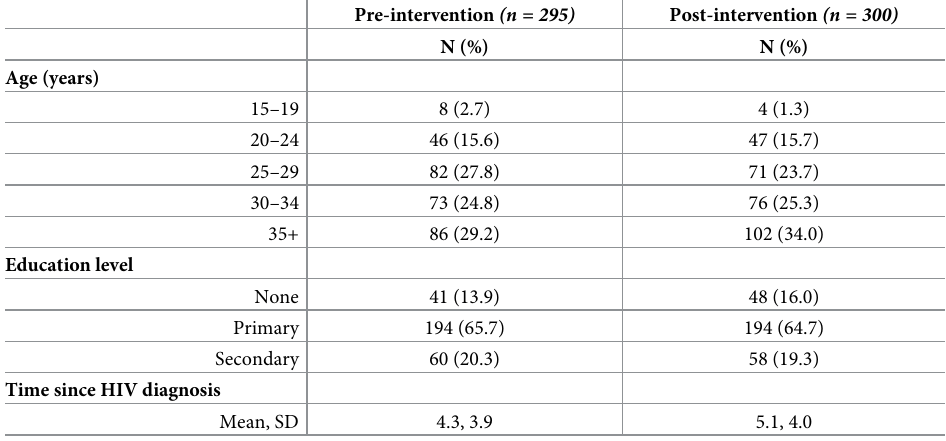
characteristics of the PMTCT clients at pre- and post-intervention were similar, as shown in Table 3. The mean age and SD of the PMTCT clients were similar pre- and post-intervention at ages 30 (6) and 30 (7) years respectively. Similar proportions of clients attended primary school or less; 79.7% (235/295), and 80.7% (242/300) respectively. The mean time (SD) since HIV diagnosis was 4.3 (3.9) months for the pre-intervention clients and 5.1 (4.0) months for the post-intervention clients. Newly and previously diagnosed PMTCT clients’ demographics were also similar. Most of the HCWs interviewed were nurses or midwives (39.1% and 37.5% pre- and post- intervention, respectively). Most of the providers were from health centers (78.1% at pre- and post-intervention), as shown in Table 4. The majority had graduated more than four years prior and had at least 2 years of experience in their current role (data not shown). Table 5 notes measures for collective and self-efficacy. The collective efficacy scale average demonstrated significant improvements for PMTCT clients at pre-/post-intervention, (p = 0.003). HCW self-efficacy scale average for delivering quality services and participation were high at baseline and did not improve post-intervention, p = 0.91 vs. p = 0.87.